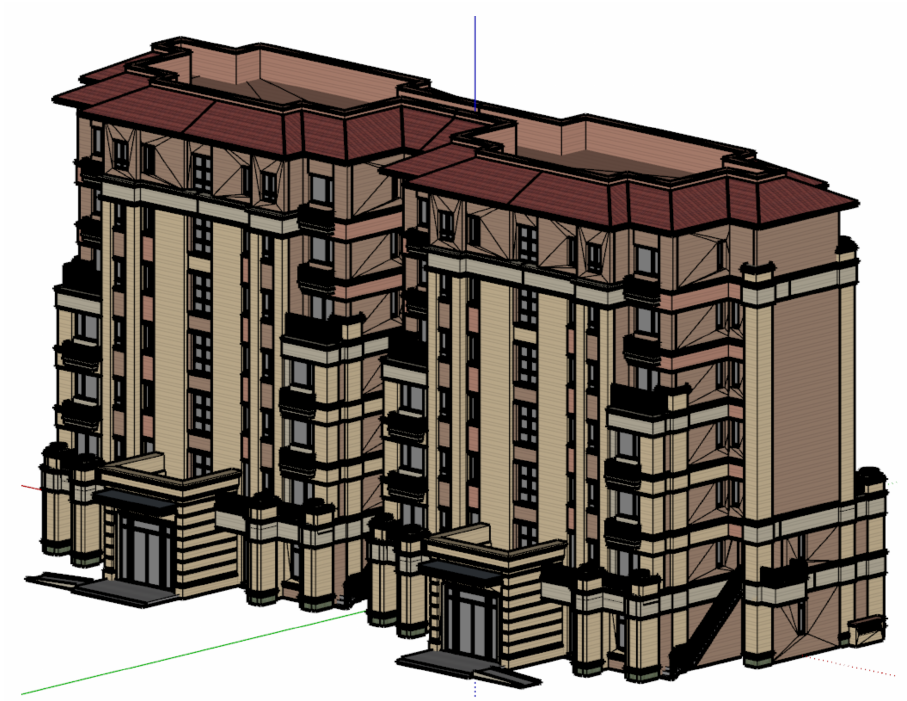
Figure 3. 3D building update model